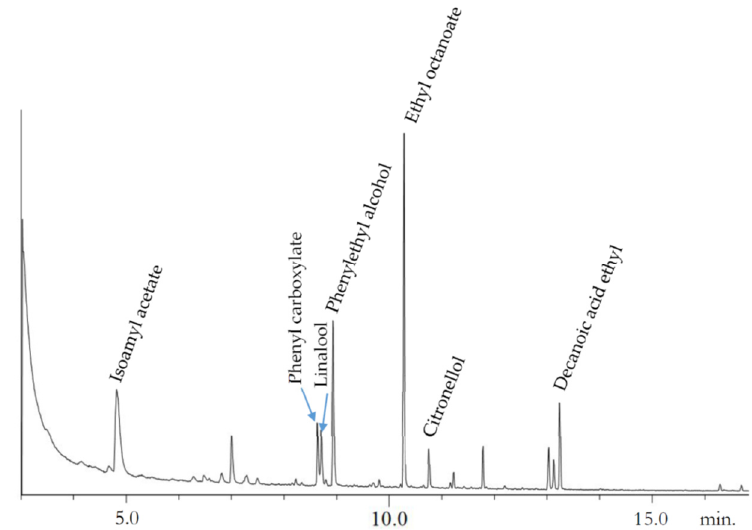
Figure 2. GC–MS chromatogram of whole wheat bread beer.